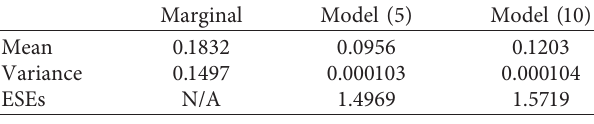
Table 1: Estimated mean and variance of